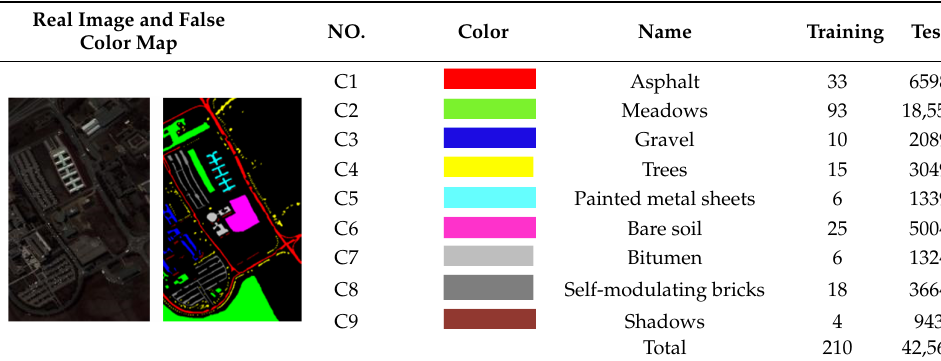
Table 2. Real image, false color map, and number of samples available in the Pavia University (UP)